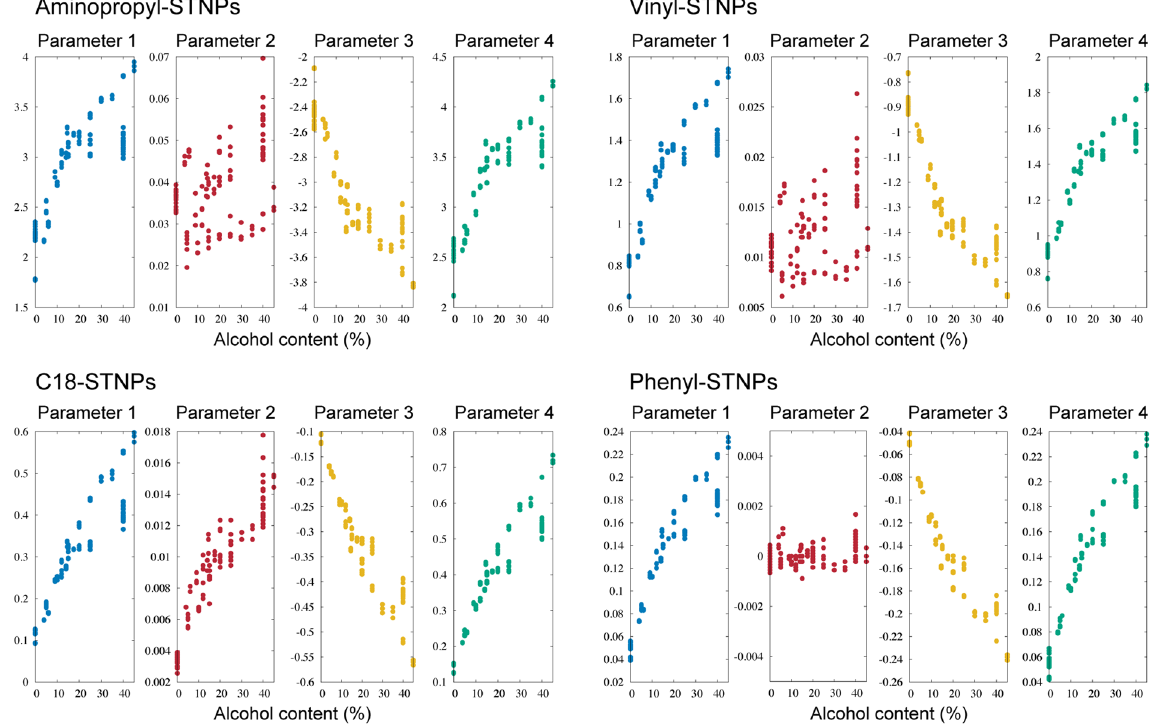
Figure 8. Alcohol content dependence of the parameters extracted from response signals under an ambient parameters 1, 3, and 4 are useful to train the ML model for the alcohol content. On the other hand, at this stage, we were not able to conclude that which receptor layer materials were suitable for estimating the alcohol content. By using these extracted parameters, we performed KRR for the responses of each receptor layer material. We first analyzed the case that a single sensor channel in the MSS was used. We trained ML models to predict the alcohol content of liquors for all combinations of the four parameters; accordingly, the number of trained ML models for each receptor layer material was 15 = 2 4 − 1. The 32 liquid samples out of 35 (except red wine, imo-shochu, and whisky) were used for the training as a known dataset. We trained the ML model by 96 signals where three signals were used in each liquid sample. Top figures of Fig. 9 show the prediction error Δ depend- ing on the combination of parameters when the 24-fold cross validation was adopted. The optimal value of the prediction error in each receptor layer material and the optimal combination of parameters are summarized in Table 1. It is suggested that C18-STNPs and Phenyl-STNPs are more useful to predict the alcohol contents of liquors compared to Aminopropyl-STNPs and Vinyl-STNPs. In addition, it was confirmed that parameter 2 was not informative to predict an alcohol content. Furthermore, we show the parity plot of predicted alcohol content versus actual alcohol content in bottom figures in Fig. 9 when we used the optimal combination of the parameters. The blue points denote the known liquid samples which are used to train the ML model and the red points are the unknown liquors: red wine, imo-shochu, and whisky. For the known liquors, the prediction by the ML model was successful when a receptor layer material was C18-STNPs or Phenyl-STNPs, while Aminopropyl-STNPs and Vinyl-STNPs showed much larger prediction errors. Judging from these results, it seems important to use hydro- phobic receptor layer materials to predict the alcohol content of liquors. On the other hand, the prediction per- formance for the unknown liquor was still not sufficient even if C18-STNPs or Phenyl-STNPs was used. It should be noted here that, by using the ML technique and evaluating the prediction error, effective receptor materials can be selected depending on the target. We also confirmed that the same results were obtained in the case under a N 2 environment (results are described in Supplementary Figure (Figure S4) and Supplementary Note sections). To improve the prediction performance further, we investigated the case of training the ML model using the MSS with all four sensor channels coated with hydrophobic materials. In addition to C18-STNPs and Phenyl-STNPs, we utilized two commercial hydrophobic polymers: polysulfone and polycaprolactone (in Supplementary Figures (Figures S5, S6 and S7) and Supplementary Note sections, all the data including measured responses, and the training results by using each polymer are shown.). In this case, since the features of a signal by each polymer were also expressed by the four parameters explained above, the 16 parameters were obtained from the four sensor channels in the MSS. The ML models to predict the alcohol content of liquors were constructed for all combinations of the 16 parameters; accordingly the number of trained ML models was 65535 = 2 16 − 1. By performing 24-fold cross validation, prediction errors Δ for all the combinations were evaluated, and the optimal combination was found. In the optimal combination (the parameter 3 of phenyl, the parameter 4 of poly- sulfone, and the parameters 1 and 3 of polycaprolactone), the prediction error was Δ = 0.4315, meaning that the